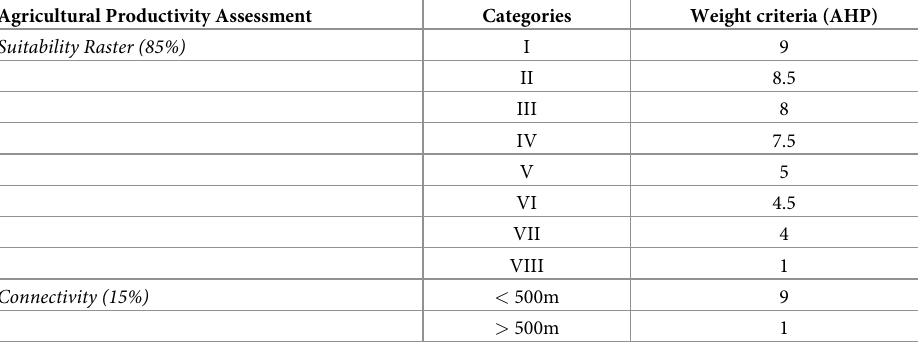
Table 3. Composition of geo-sampling method